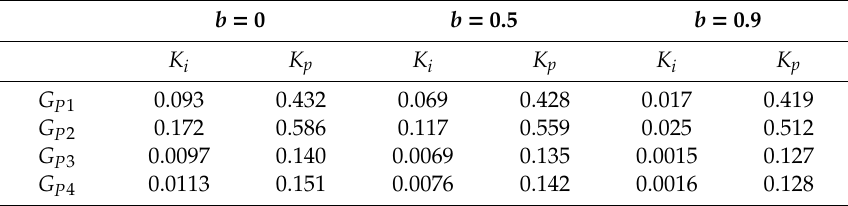
Table 2. PI controller parameters for di ff erent process models and parameter b . b = 0 b = 0.5 b =